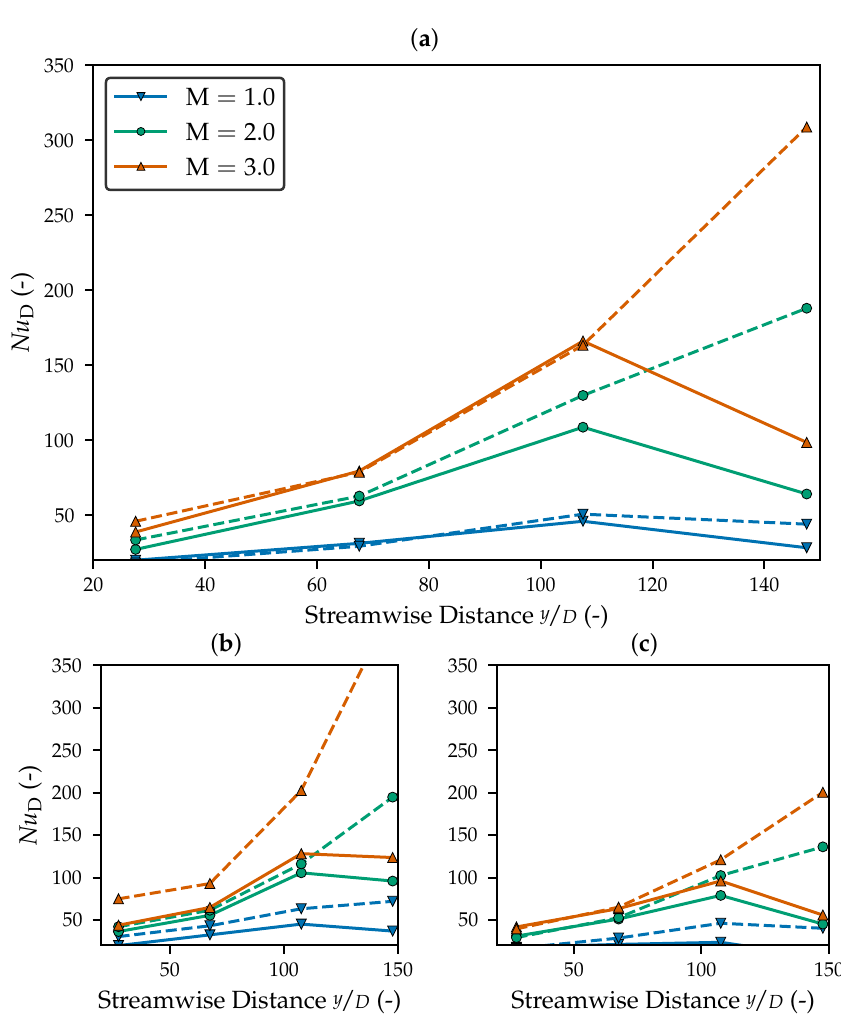
Figure A2. Nusselt numbers over streamwise length on the cavity side of the effusion specimen averaged in the eff area. ( a ) Nominal cavity height 5 D at top, ( b ) small cavity height 3 D bottom left, ( c ) large cavity height 7 D bottom right. Solid lines show aligned setup MALO00 ; dashed lines show misaligned setup MALO05 . Table A3. Standard deviations of cavity side Nusselt number for each of the averaged data points ( eff area) shown in Figure A2. M = 1 M = 2 M = 3 Wind. # Wind. # Wind.